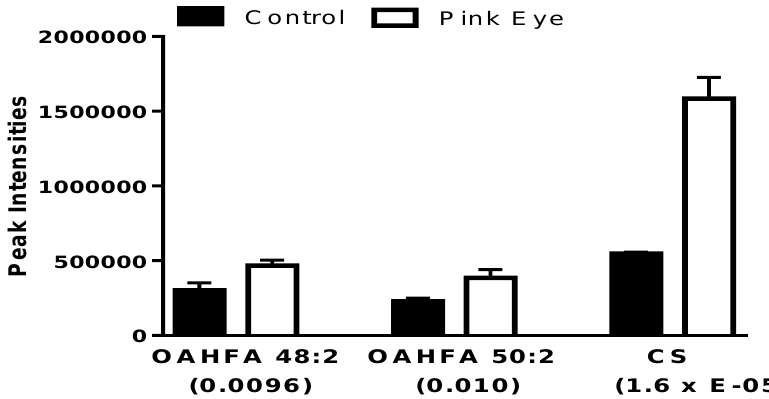
Figure 2. Charged anionic lipids in bovine tear fluid. Data are presented as peak intensities for the ions of each of the lipids ± SEM. OAHFA, (O-acyl)-ω-hydroxy-fatty acid; CS, cholesterol sulfate. p values are in brackets.